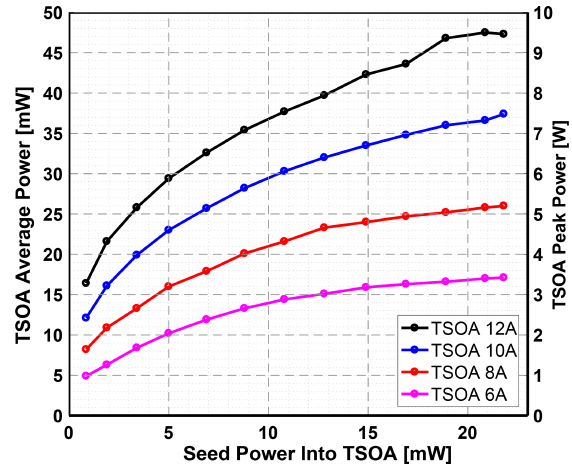
Figure 5. Power output of the free-space TSOA seeded with the two-stage butterfly-packaged seed laser module. TSOA operated with 0.625µs duration 8kHz pulses at the drive current shown.